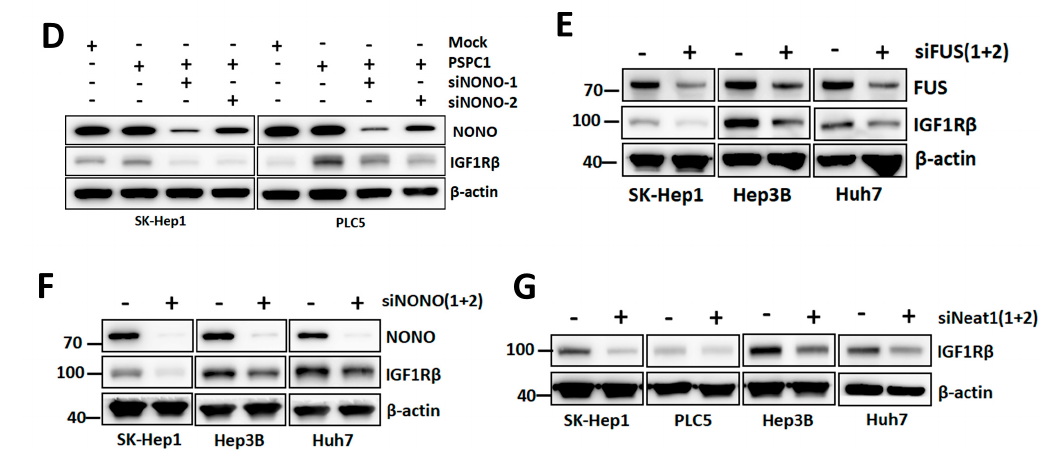
Figure 6. Paraspeckle core components PSPC1, FUS, NONO, and lncRNA Neat1 are essential for IGF1R induction. ( A ) Total cell lysates of Huh7 cells were immunoprecipitated using the PSPC1 antibody and then conducted SDS-PAGE for protein separation and stained with Coomassie Blue (left panel). Bands indicated by arrows were excised for in-gel digestion and LC-MS / MS analysis. A total of 141 interacting proteins were analyzed for protein–protein interaction networks by STRING (right panel). ( B ) The ranking list of top six PSPC1-interacting proteins in descending ordered by MASS score. ( C , D ) Depletion of FUS and NONO by siRNAs in PSPC1-overexpressing SK-Hep1 and PLC5 cells cultured for 2 days following performed immunoblotting assay for detection of IGF1R expression. ( E–G ) IGF1R expression diminished by immunoblotting analysis in knockdown of FUS, NONO, or Neat1 with corresponding siRNAs in parental SK-Hep1, PLC5, Hep3B, and Huh7 cell lines cultured for 2 days.